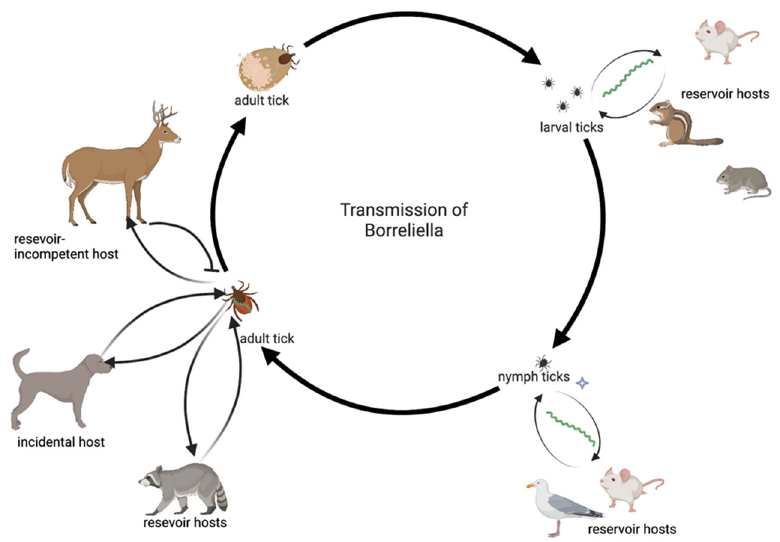
Figure 2. Transmission and acquisition of Borreliellal spirochetes. The image was created in BioRender by KM Socarras 2022 .